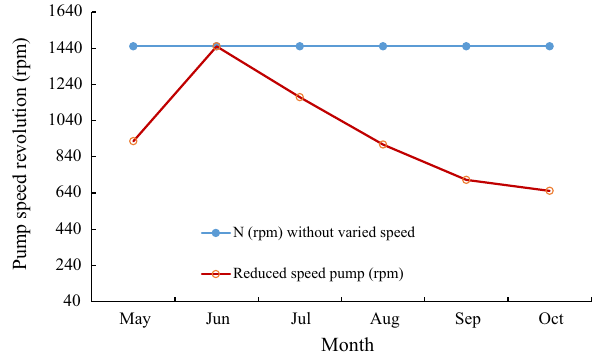
Fig. 7 Variation of pump impeller rotation in different months for fixed speed pump and variable speed pumps